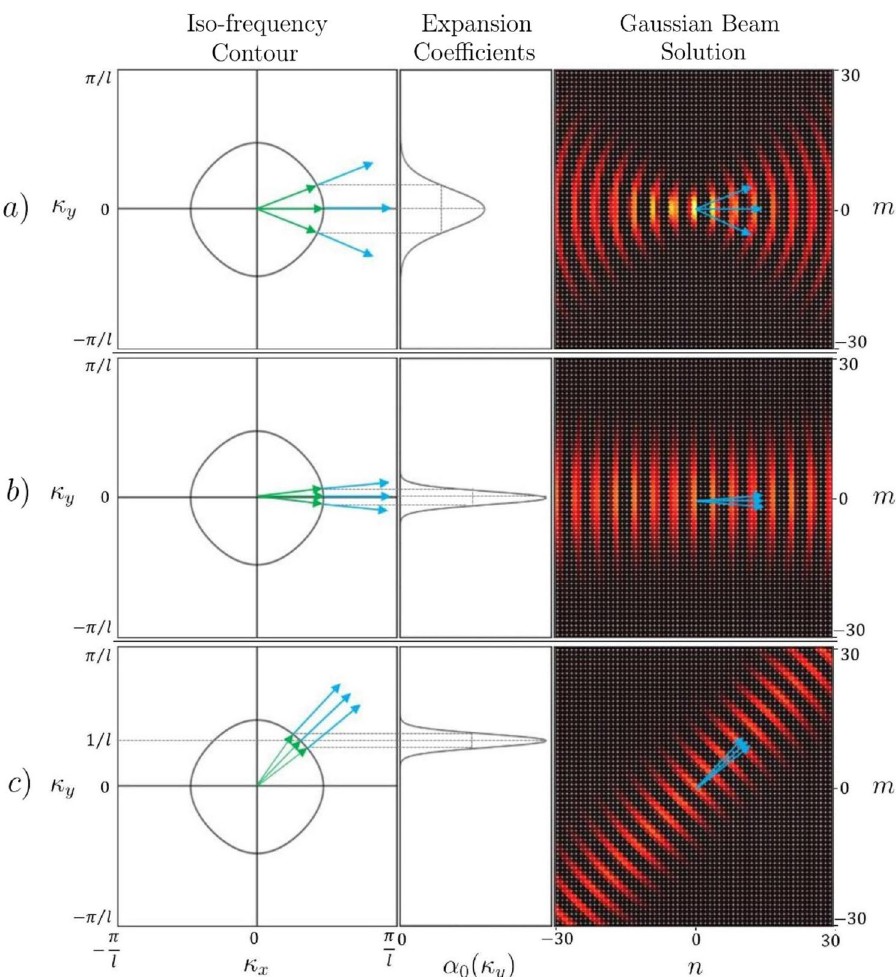
1 / l as defined in (17) at k point =